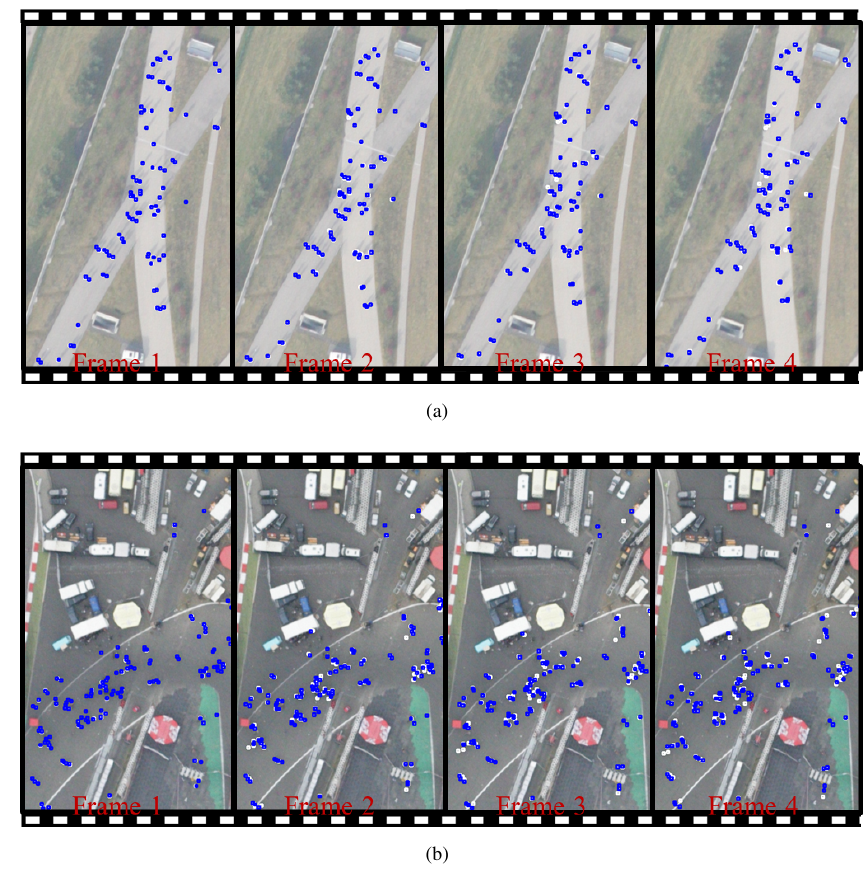
Figure 7. Sample illustrations of the tracking results for the vehicle dataset based on GOT-NF-3Conv/150